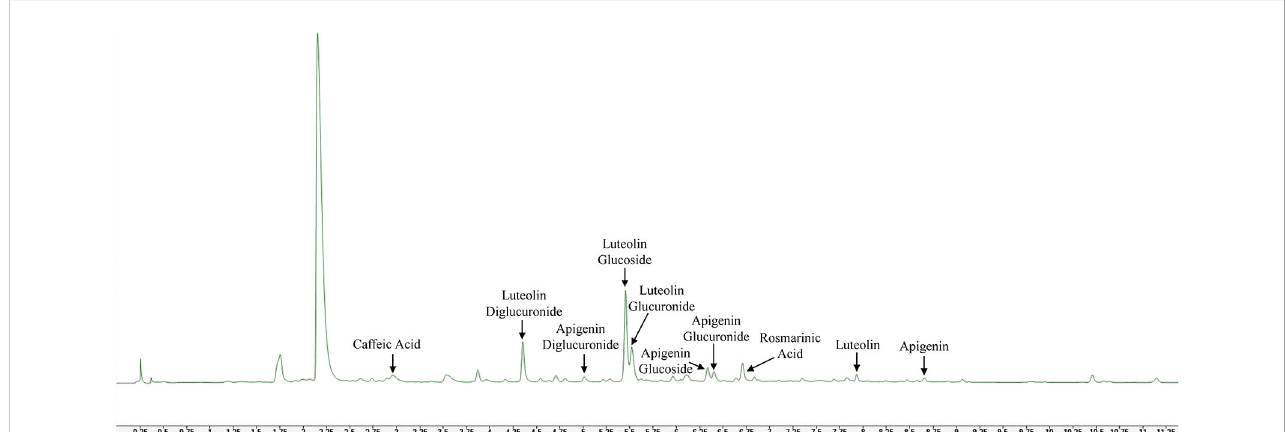
FIGURE 5 Representative UHPLC/UV chromatogram (320 nm) evidencing phenolic acids, fl avones and fl avone glycosides in methanolic extracts of leaves from catnip cultivar